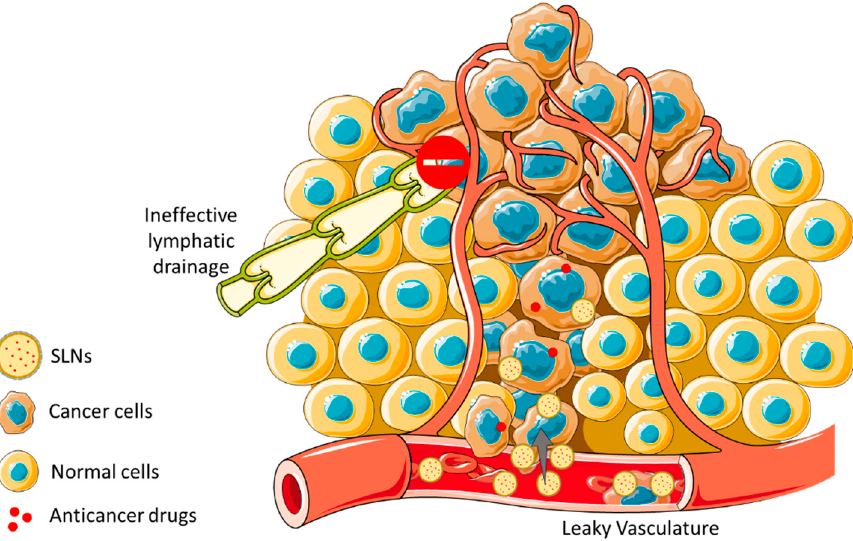
Figure 5. Schematic illustration of the EPR effect and nanoparticles uptake through size across can- cerous tissues. EPR effect promotes an increased accumulation of nanoparticles in cancer cells facing normal cells, due to the leaky vasculature within the tumor region being allied to a dysfunctional lymphatic system.